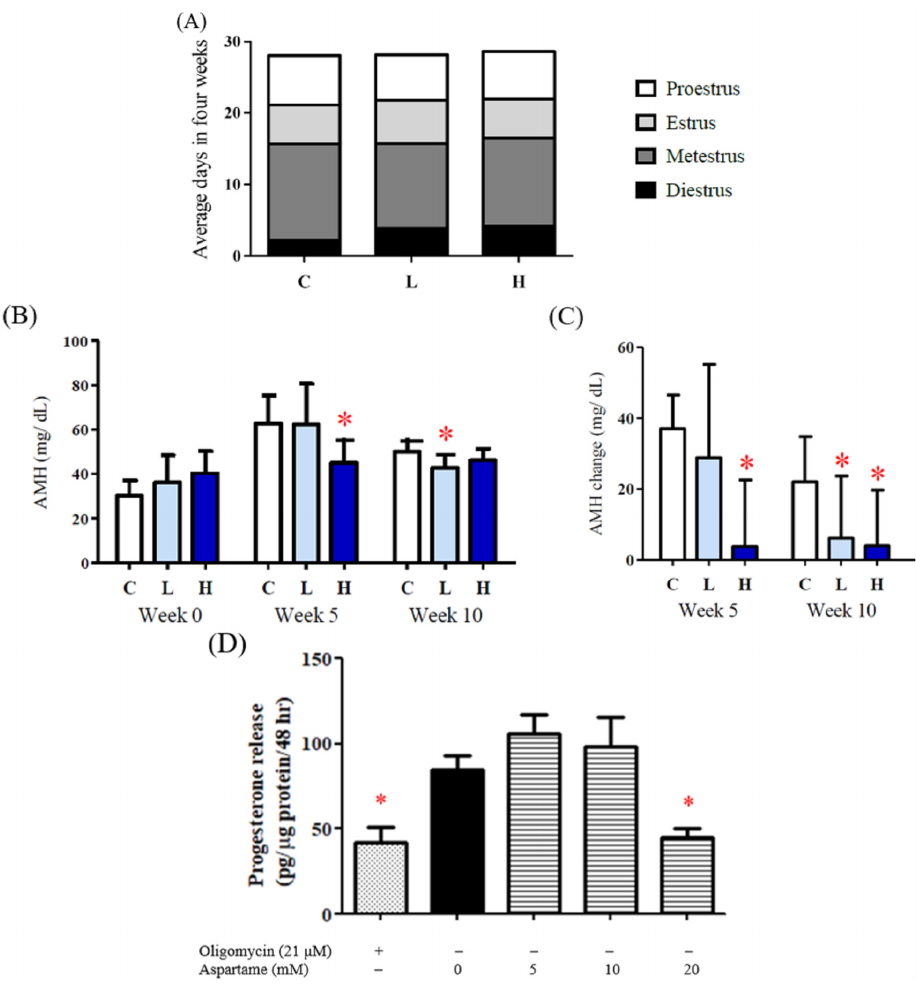
Figure 4. Effect of aspartame treatment on estrus cycle, serum AMH, and progesterone release in rats and cells. Serum AMH and progesterone secretion decreased more in the group treated with aspartame. ( A ) Estrus cycle of different experimental groups after 8–12 weeks intervention. Data were accessed from the result of the vagina smear. ( B ) Serum AMH, a reproductive-related hormone, in weeks 0, 5, and 10. AMH is distinguished from the data from other ages, as it can only be com- pared with the results in the same age. ( C ) Change of serum AMH in different treatment groups. ( D ) KGN cells treated with 20 mM aspartame significantly decreased progesterone release, which is highly correlated with ATP production. All data are expressed as mean ± SD. * p < 0.05 as com- pared with control. C, control. L, low dose of aspartame. H, high dose of aspartame. AMH, anti- mullerian hormone.